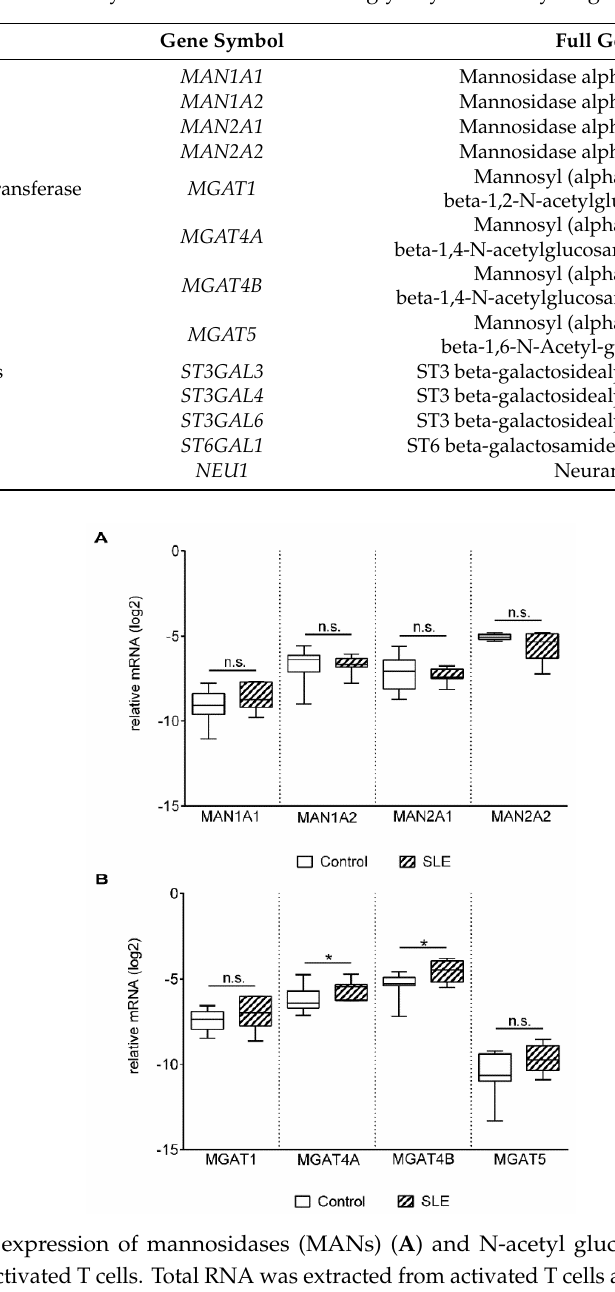
Table 2. Symbols and full names of glycosylation enzyme genes.